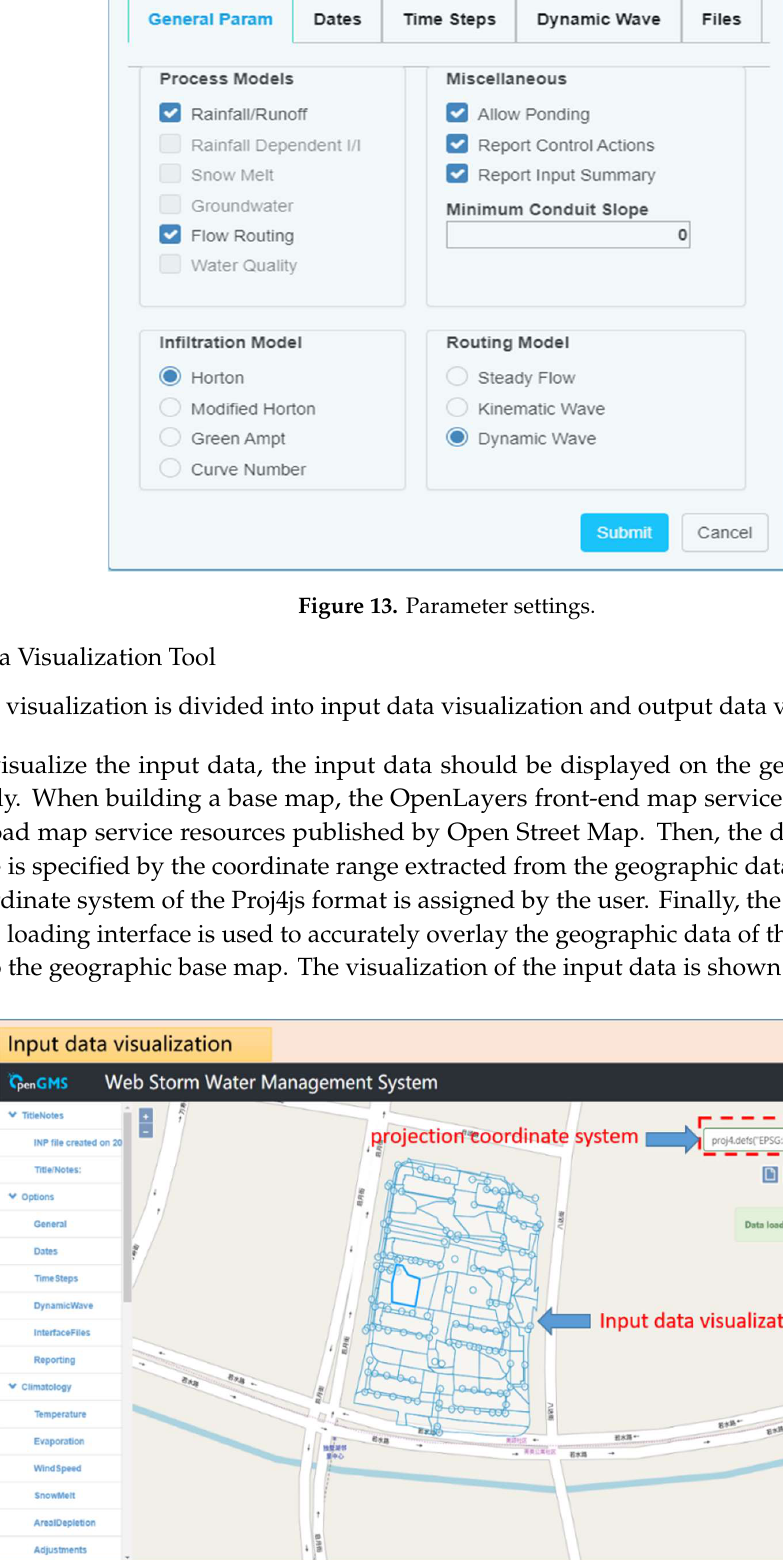
Figure 12. Data editing tool.